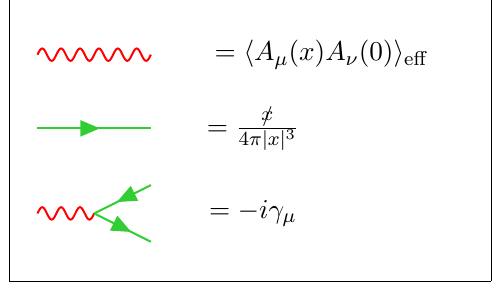
Table 8 . (fQED) Feynman rules for propagators and